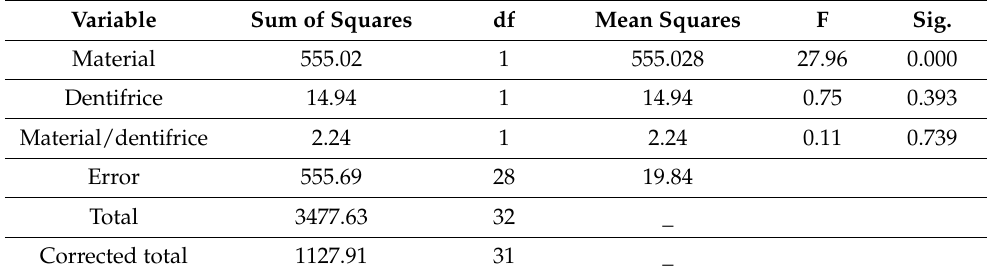
Table 5. Overall influence of material and dentifrice on the micro-hardness (VHN) using two-way ANOVA. Variable Sum of Squares df Mean Squares F Sig. Material 555.02 1 555.028 27.96 0.000 Dentifrice 14.94 1 14.94 0.75 0.393 Material/dentifrice 2.24 Error 555.69 Corrected